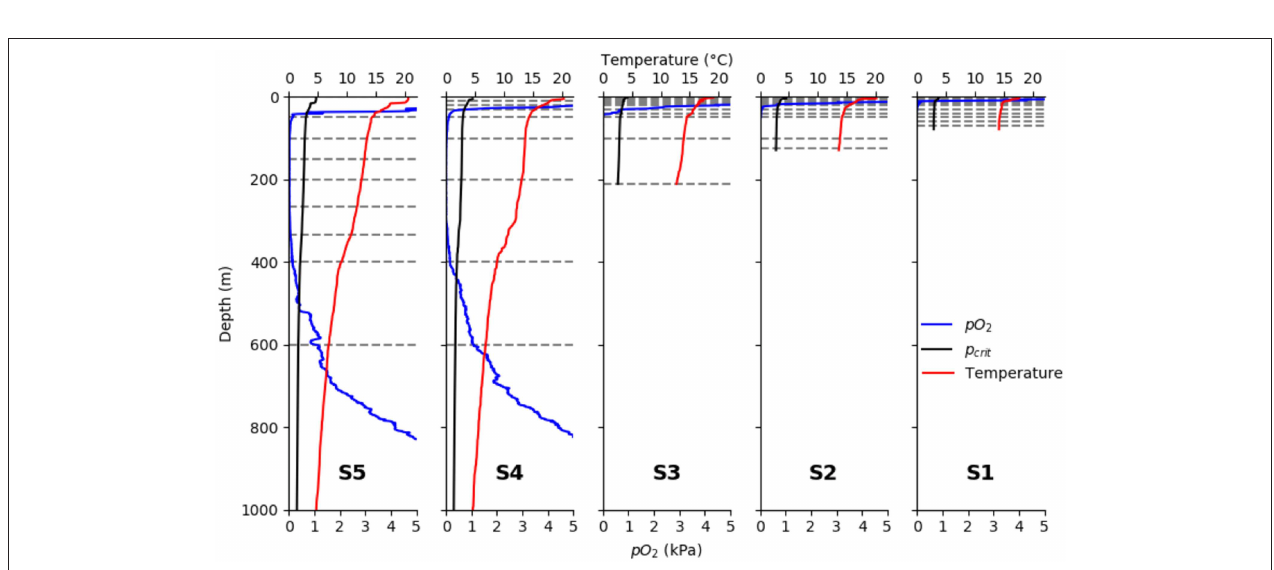
FIGURE 3 | Vertical profiles of observed pO 2 (blue), temperature (red), and p crit (black) calculated after Equation (3). From left to right: S5, S4, S3, S2, S1 horizontal gray lines denote sampling intervals of the multinet.